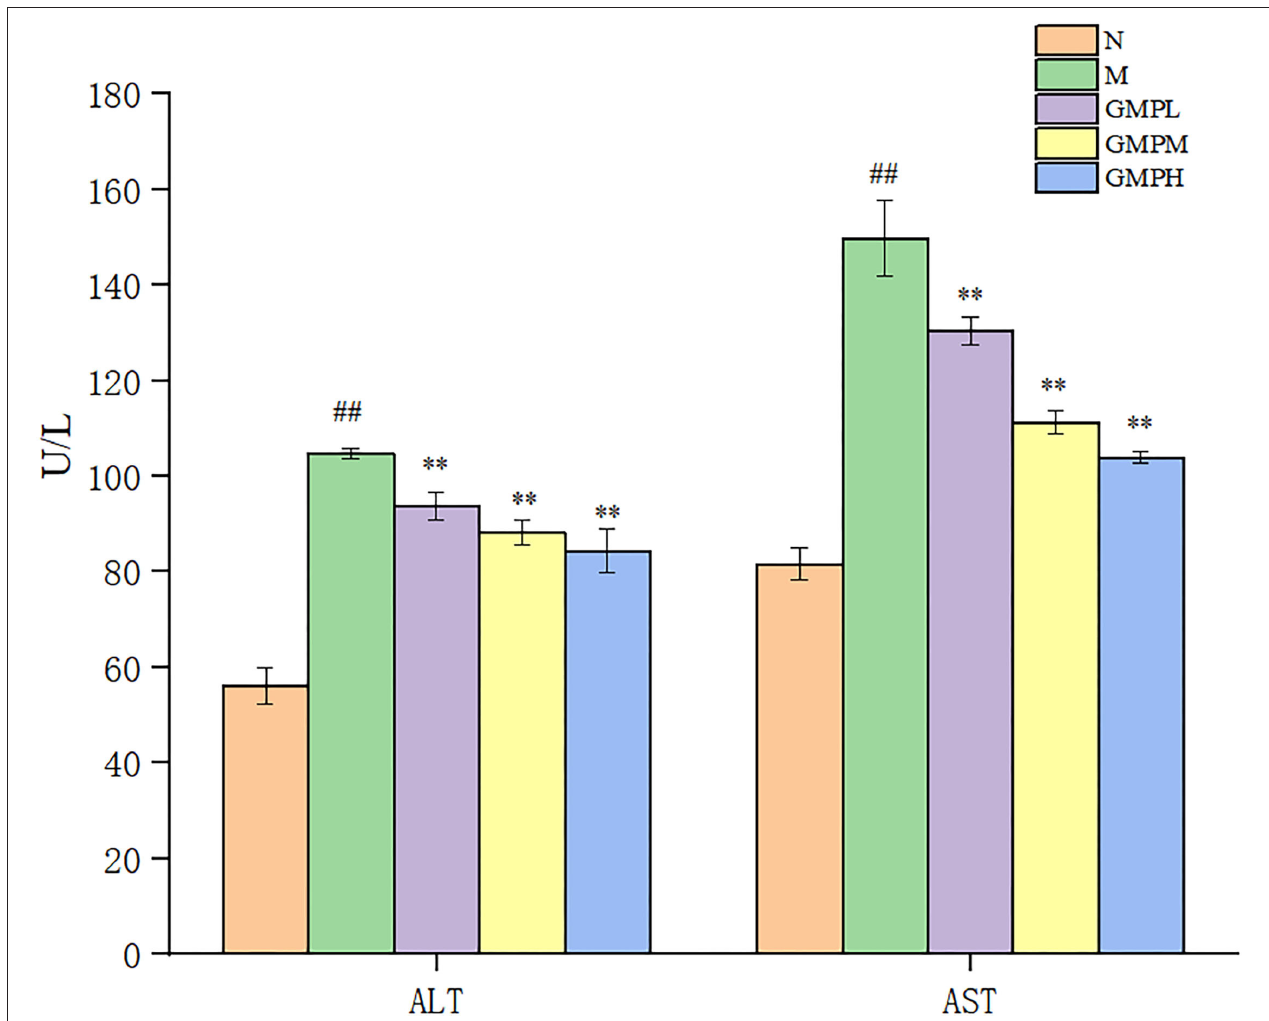
FIGURE 4 | Effects of different doses of GMP on ALT and AST. The data in the figure are expressed as mean ± SD ( n = 6). Significance of difference: *means p < 0.05, **means p < 0.001, compared with group M. ## means p < 0.001, compared with group N. GMP, germinated mung bean polyphenol; ALT, alanine aminotransferase; AST, aspartate